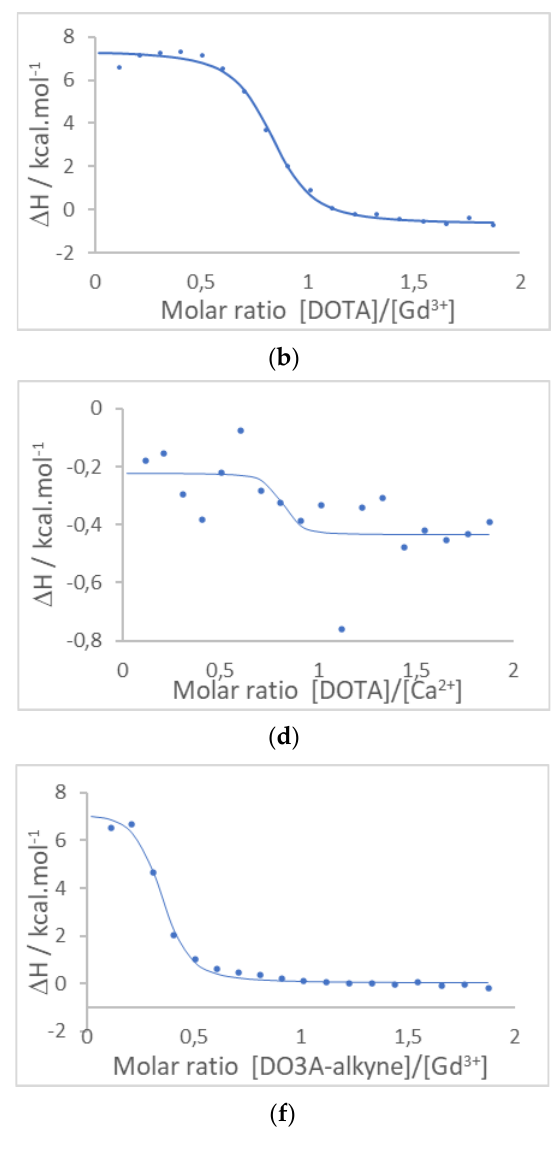
Figure 1. Isothermal titration calorimetry (ITC) results. ( a ) Raw ITC results for DOTA/Gd 3+ complex- ation and ( b ) corresponding enthalpy fit. ( c ) Raw ITC results for DOTA/Ca 2+ and ( d ) corresponding enthalpy fit. ( e ) Raw ITC results for DO3A-alkyne/Gd 3+ and ( f ) corresponding enthalpy fit. Solutions were prepared before-hand: 50 µM DOTA or 50 µM DO3A-alkyne, 500 µM GdCl 3 , 50 µM CaCl 2 . The DOTA or DO3A-alkyne solutions were inserted into the calorimeter and the system was let to equilibrate.